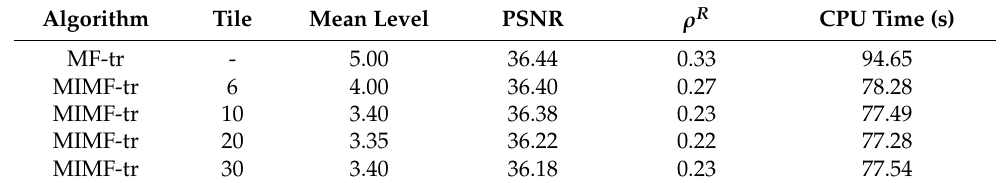
Table 1. Mean levels, PSNR, mean compression rate, and CPU times for the source image in Figure 2a.